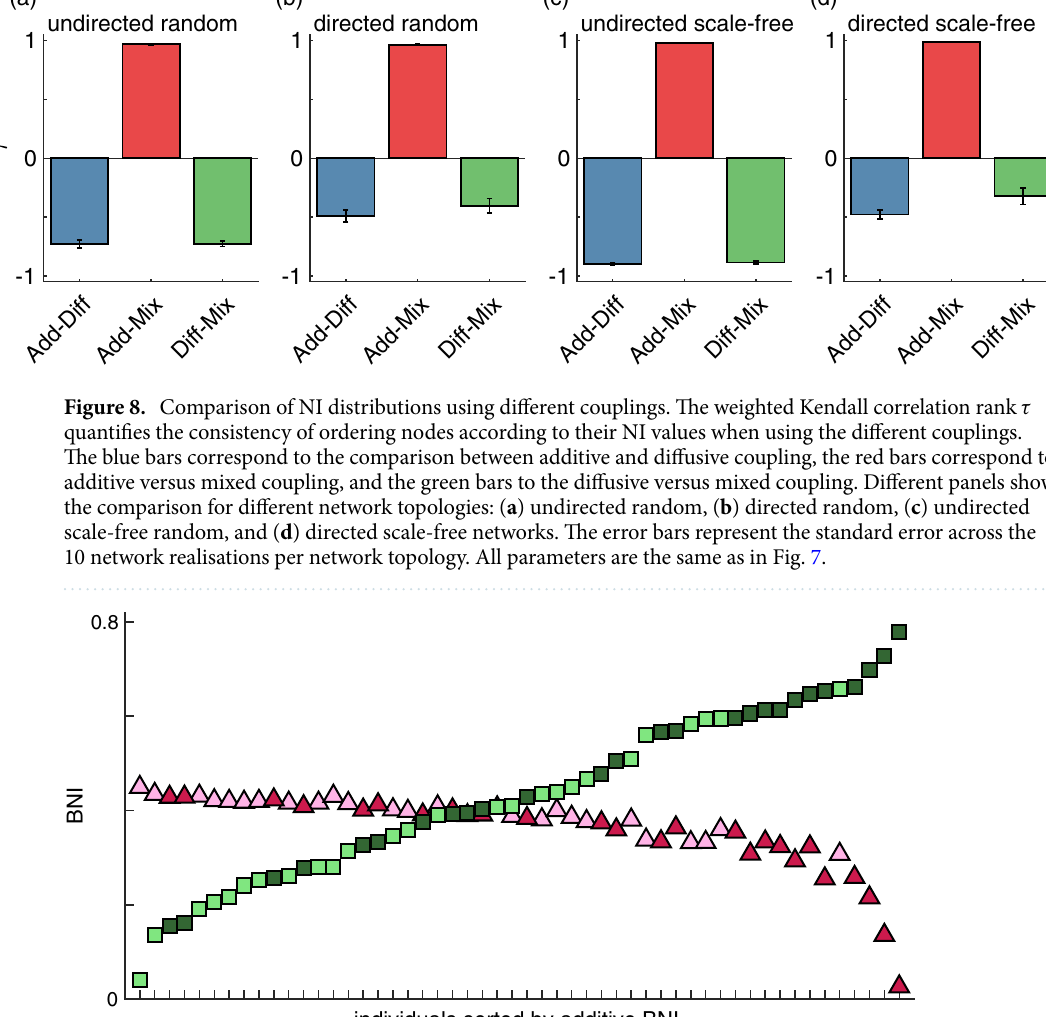
Figure 9. Comparison of BNI using additive and diffusive couplings on MEG functional networks. Each square (triangle) is the BNI value based on additive (diffusive) coupling of each individual. The individuals were sorted such that the BNI values based on the additive coupling were monotonically increasing. Light green squares and light pink triangles correspond to healthy controls, and dark green squares and dark pink triangles correspond to people with JME. We used α = 0.005 and γ = 15 for the additive coupling simulations, and α = 0.03 and β = 4.6 for the diffusive coupling